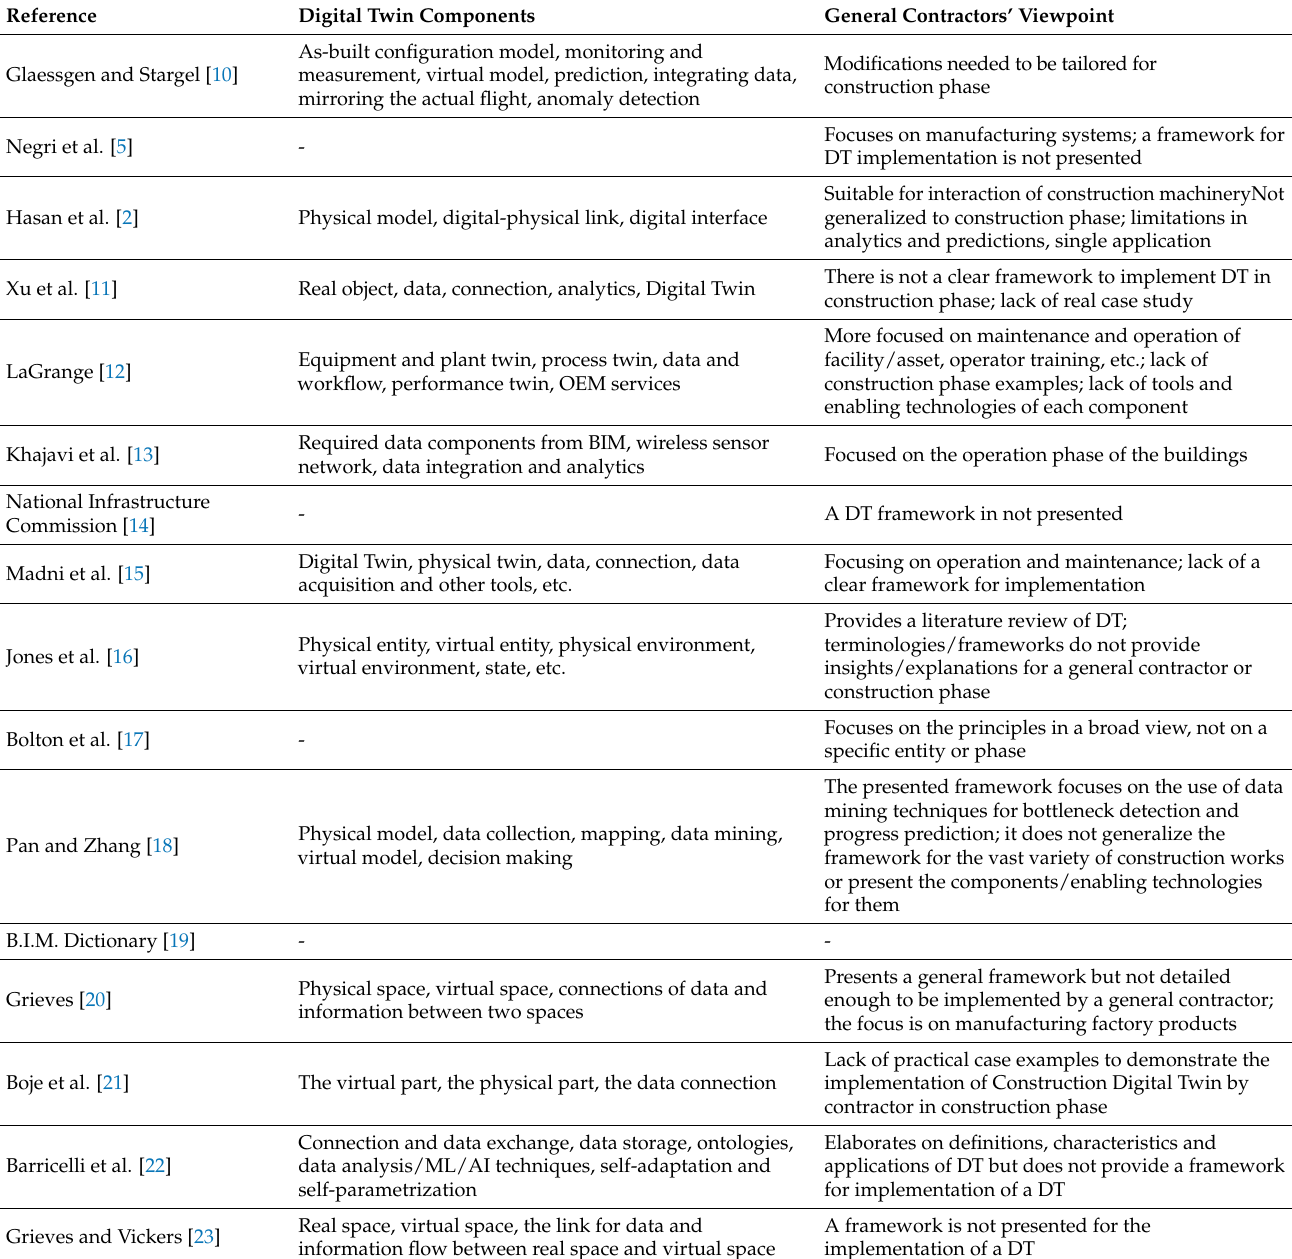
Table 2. The DT components in some of the reviewed studies and their relevance to construction